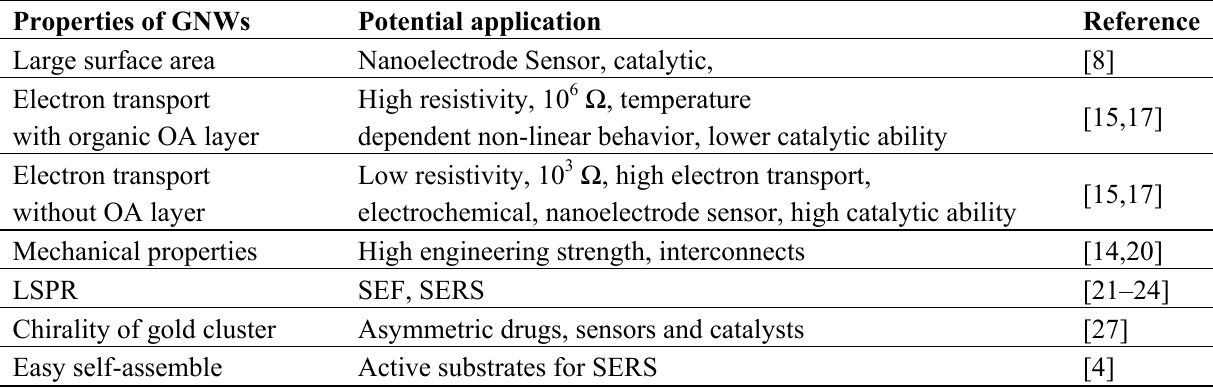
Table 1. List of properties of gold nanowires and their potential